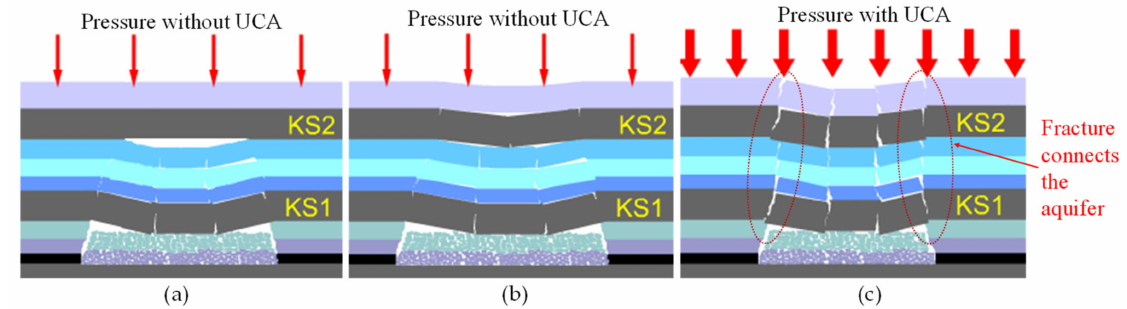
Figure 3. Schematic diagram of influence on different key stratum (KS) breakage on water flowing fracture: ( a ) KS1 breaks without UCA; ( b ) KS2 breaks without UCA; ( c ) two KSs break entirely with